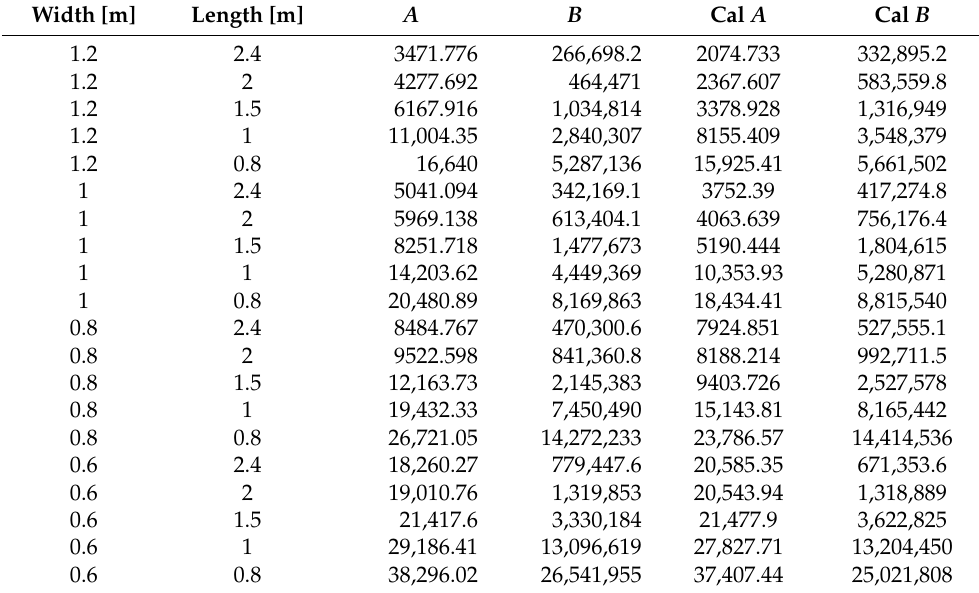
Table A11. The 10 mm plate FEA A , B and theory calculated A , B .